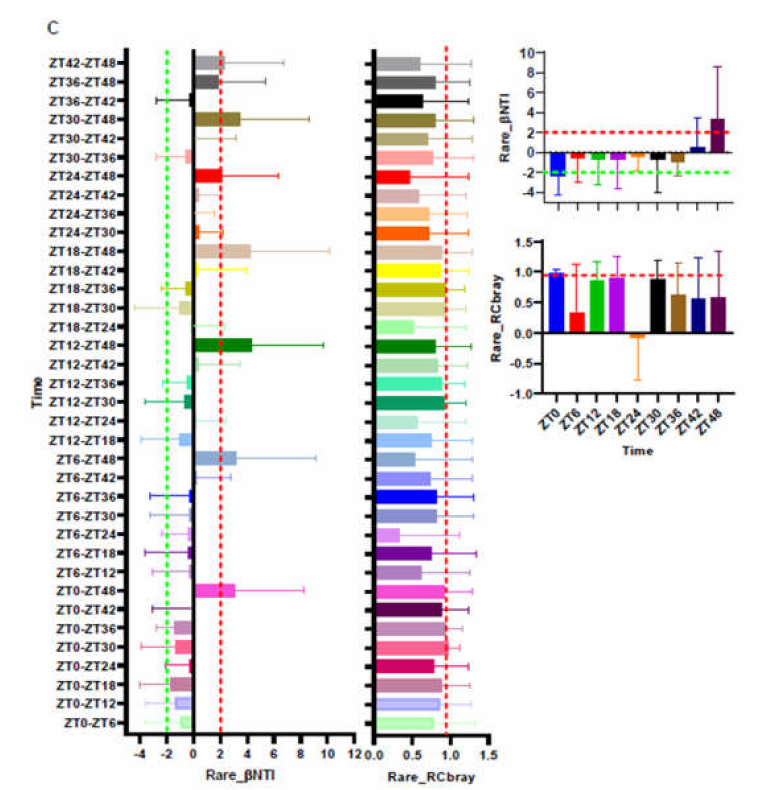
Figure 4. The Beta Nearest Taxon Index ( β NTI) of the total ( A ), abundant ( B ), and rare ( C ) bacterial communities and the Raup–Crick metric based on relative abundances of the ASVs (RC Bray ). The relative abundance of ASVs ≥ 1% and <0.1% were assigned as abundant ASVs and rare ASVs, respectively. Red (0.95 or 2) and green ( − 0.95 or − 2) lines represent critical line values.